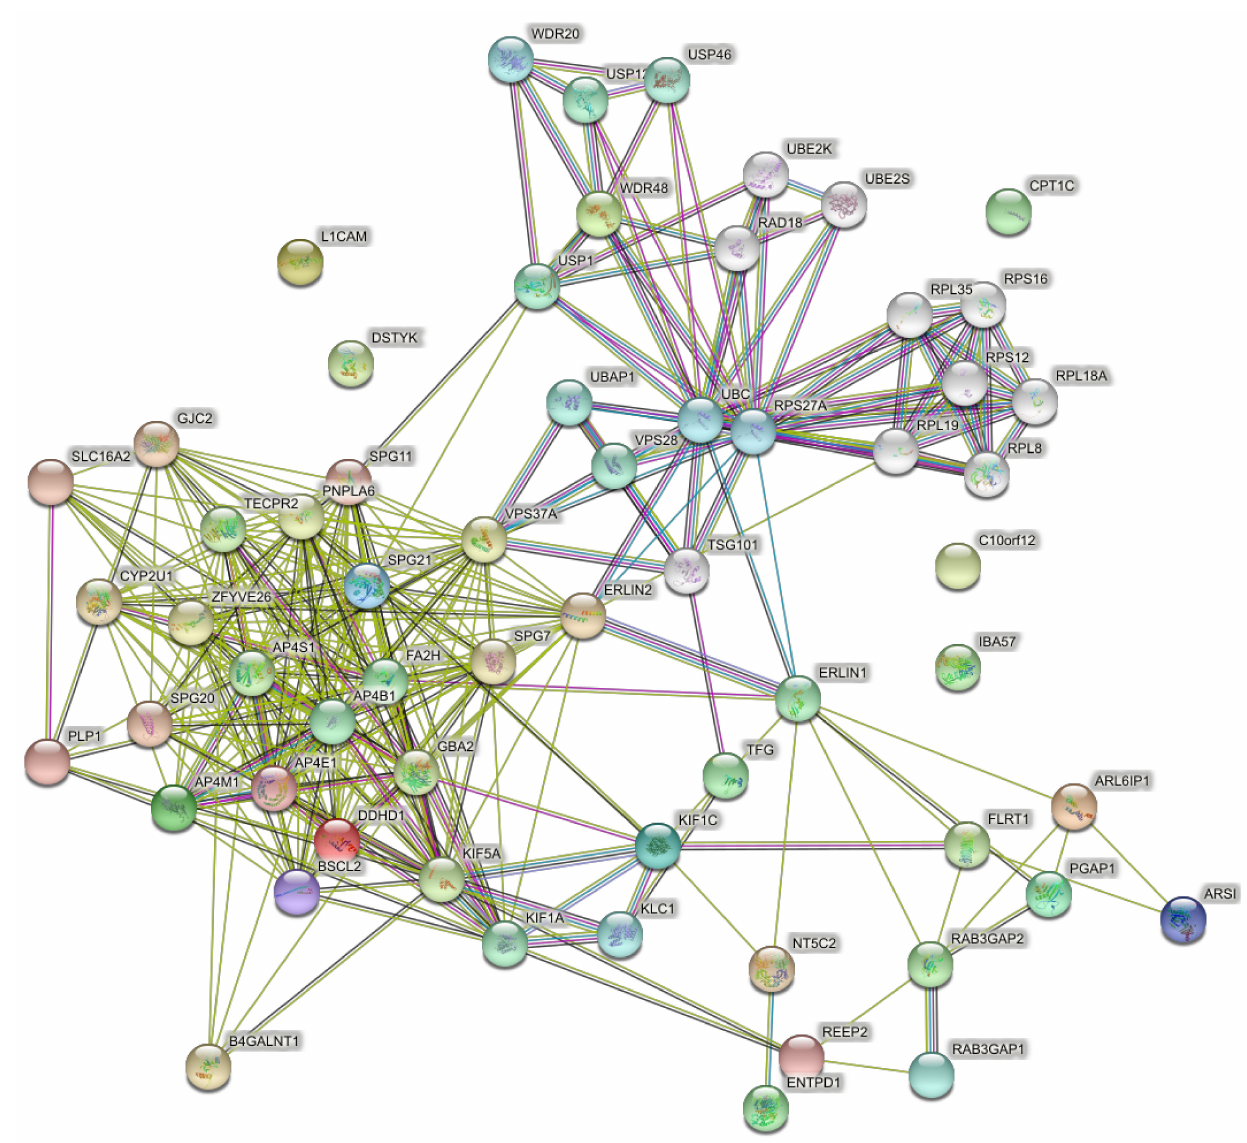
Figure 5. Predicted PPI networks for second shell interactions among 42 genes of complicated